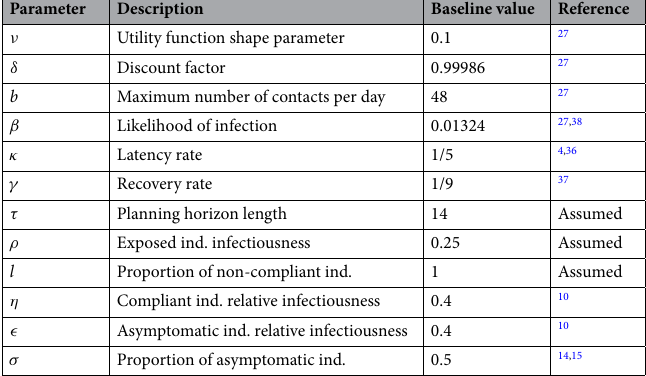
Table 1. Constant contact rates and adaptive behavior model baseline parameters.